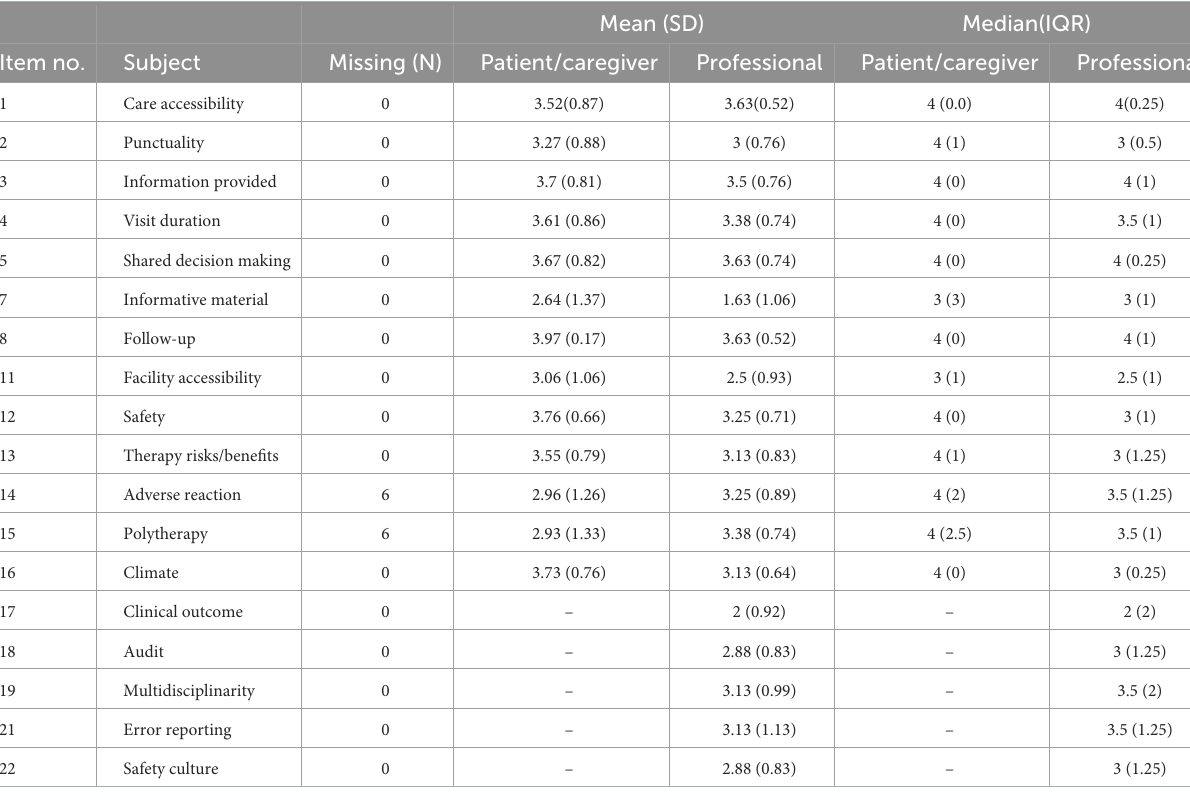
TABLE 2 Mean, SD, median and IQR of responses to each Likert item, classified by respondent group (patient/caregiver or professional).